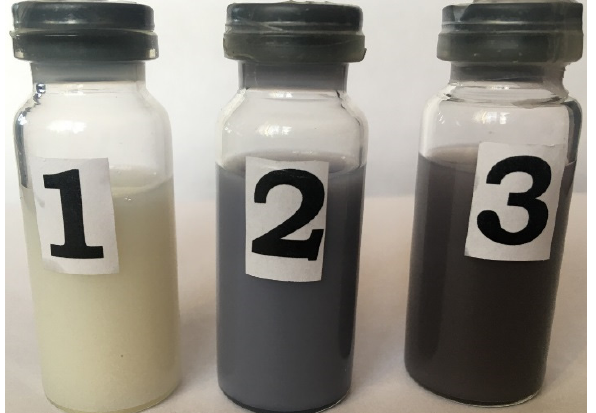
Figure 1. Colors of silver chloride sol in a solution simulating sweat after 7 days of storage: sample 1—in a dark place, sample 2—in diffused sunlight, and sample 3—in direct sunlight.